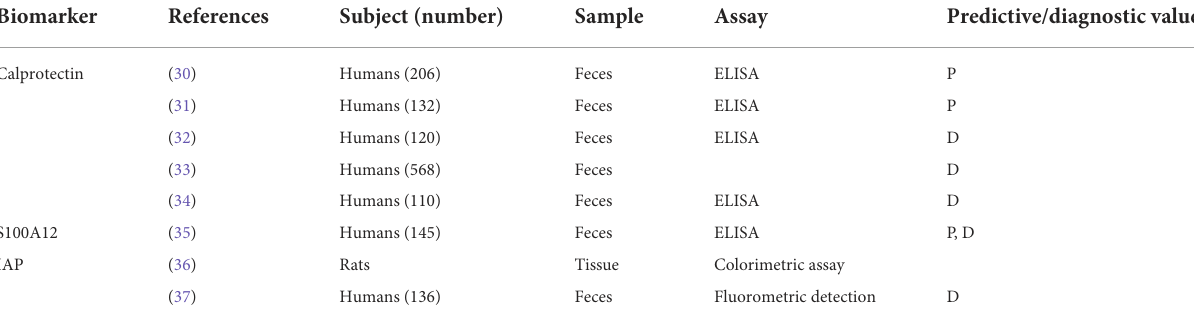
TABLE 1 Fecal biomarkers of NEC.